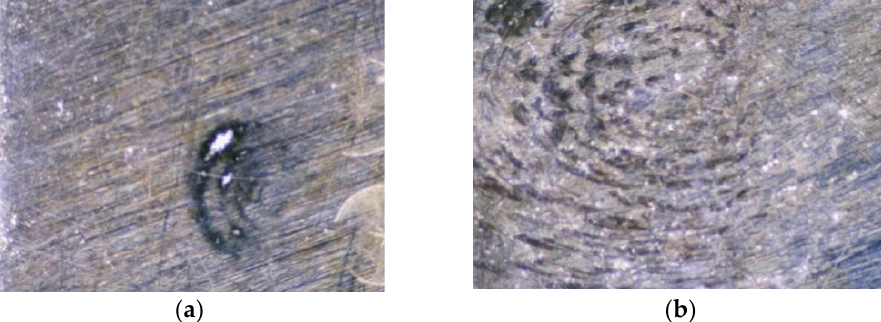
Figure 10. Film surface morphology under ( a ) before repair and ( b ) after repair with shaping laser.